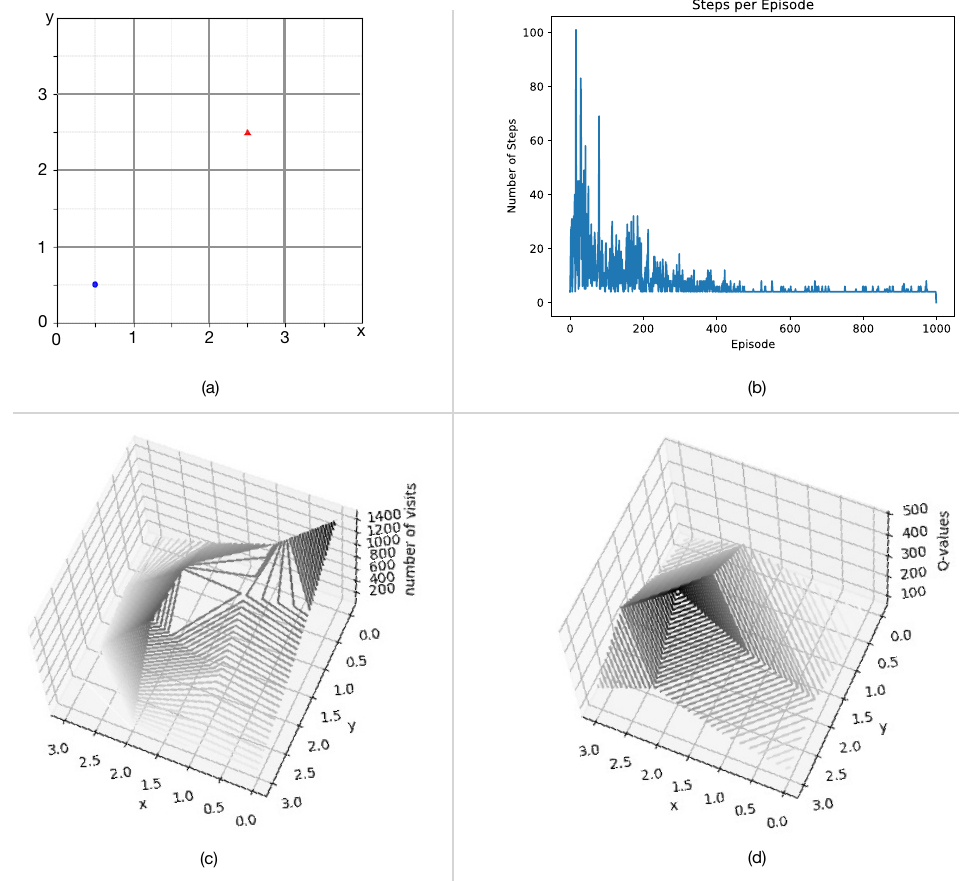
Figure 9. The single-agent, single stationary interest-point scenario. ( a ) The initial position of the agent is in cell (0,0). The interest-point is positioned in cell (2,2). ( b ) The number of training steps per episode converges to the optimum of 4. ( c ) The number of visits to each cell over the entire training process. Cells on the shortest path to the interest-point receive the most visits. ( d ) The estimated maximum q-value of each cell. Cells closer to the interest-point have more